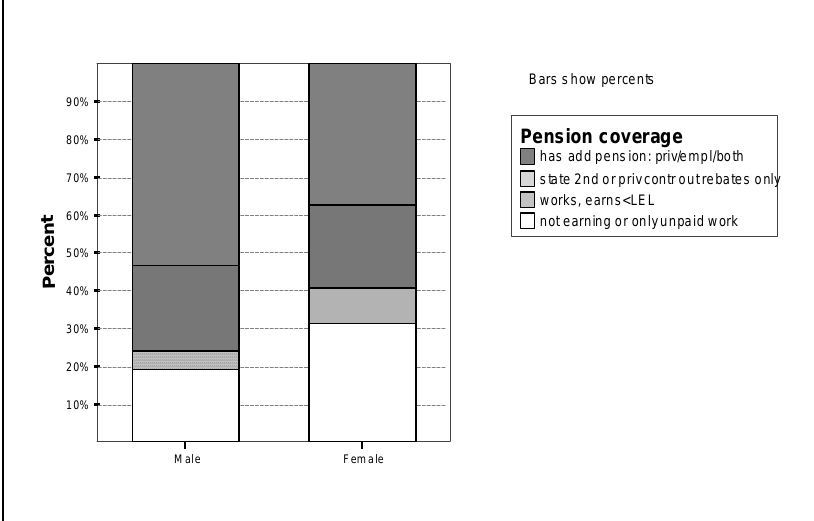
Figure 1 . Participation in State and Private Pension Schemes in the UK: men and women aged 20 to